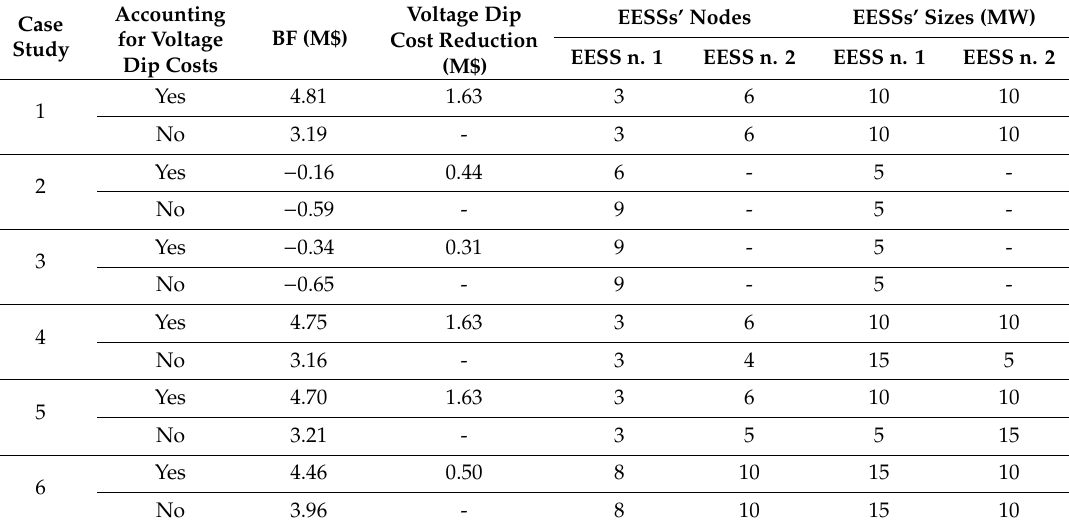
Table 5. Siting and sizing of